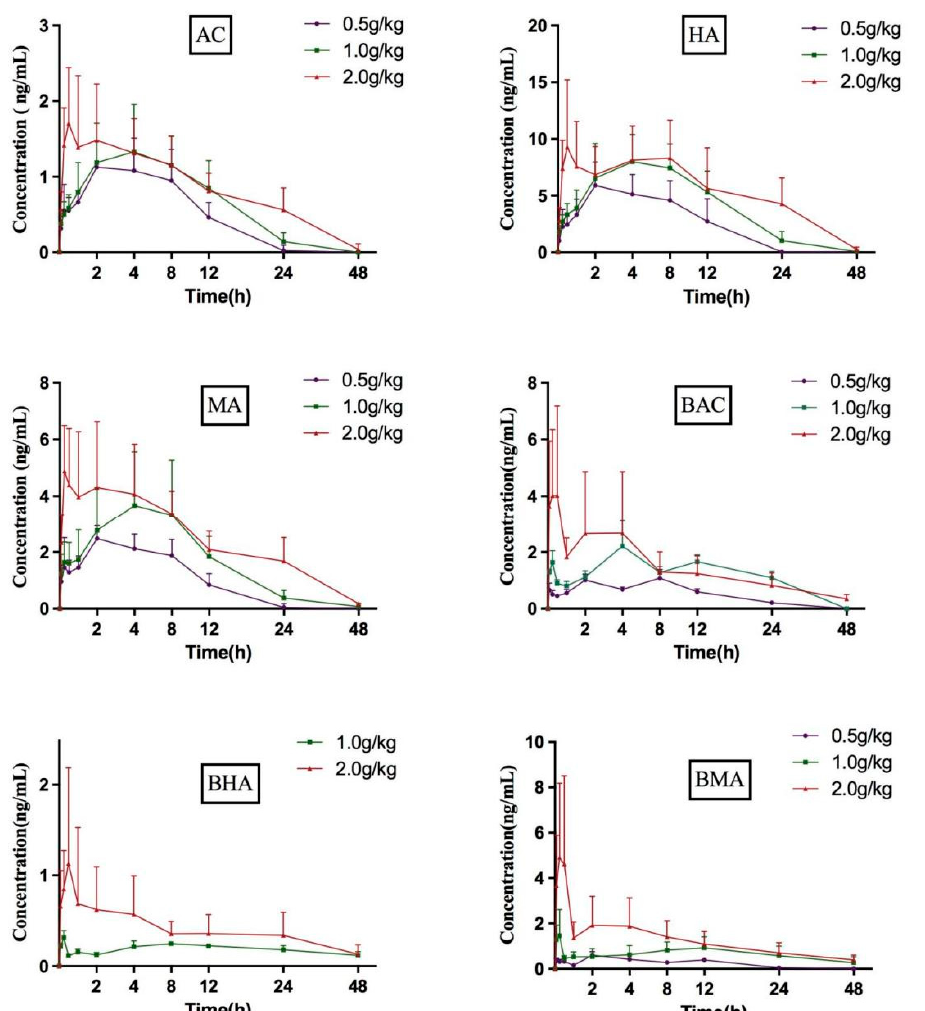
Figure 4. Plasma concentration–time profiles of the six compounds in SD rat plasma at different oral dose of 0.5 g/kg, 1.0 g/kg and 2.0 g/kg of Fu Zi extracts ( n = 8), note: concentration of BHA at 0.5 g/kg was Below the Quantization Limit. Table 5. The main pharmacokinetic parameters of the six compounds in SD rat plasma at different